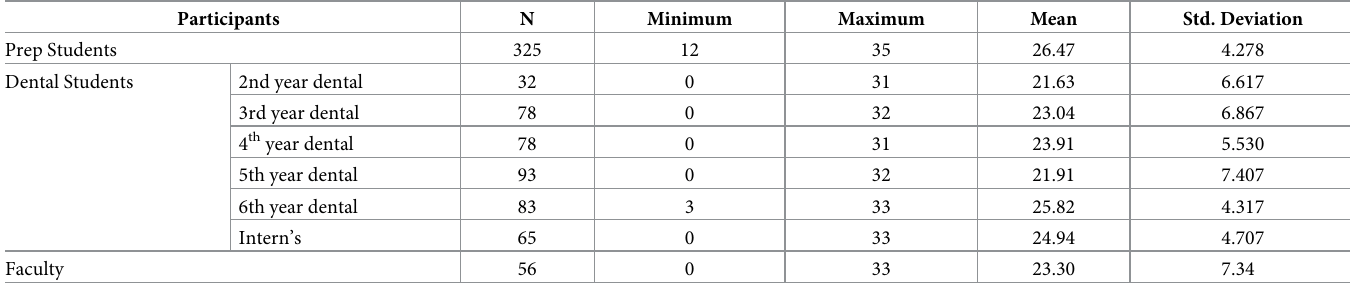
Table 1. Mean knowledge score for faculty members, dental students and preparatory year students.